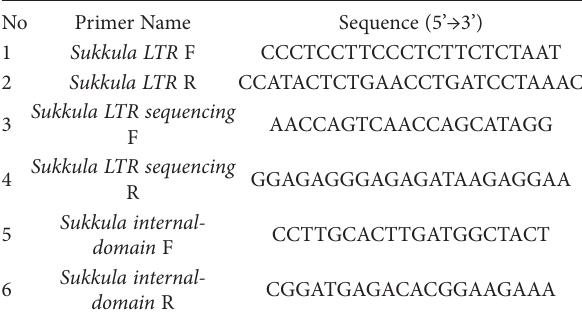
Table 1. Primers used in this